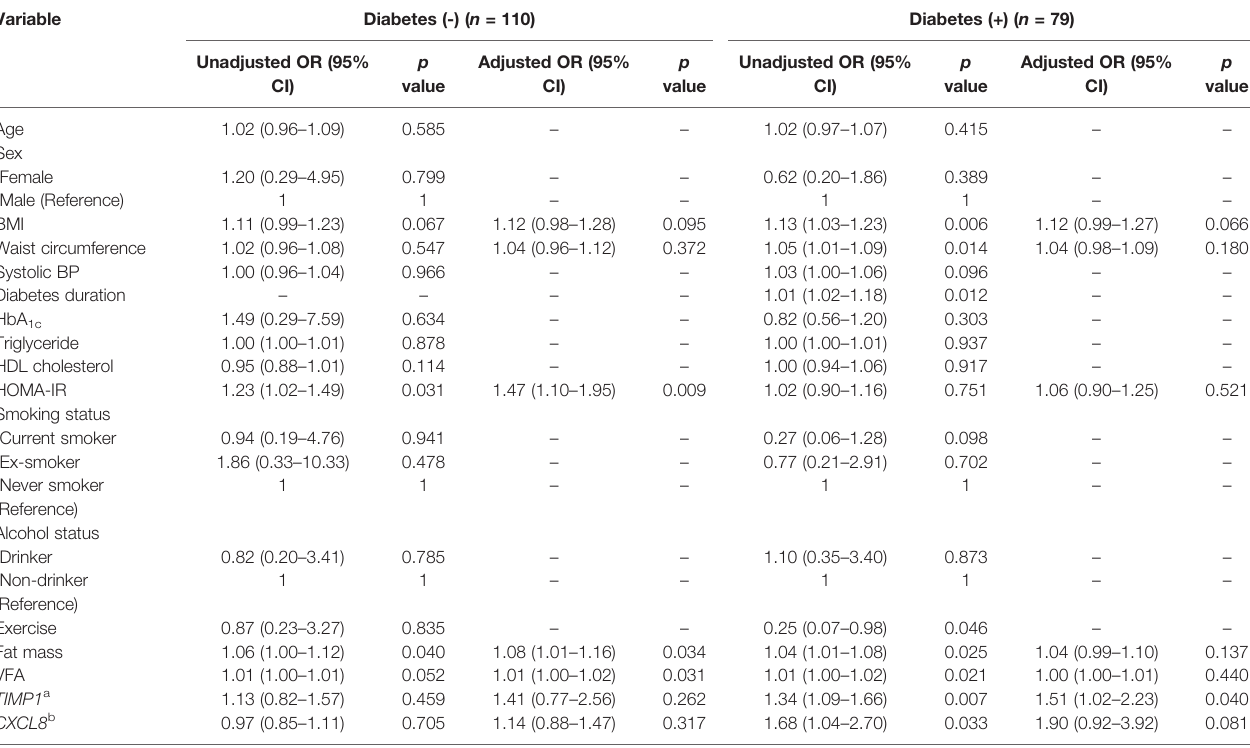
TABLE 2 | ORs and 95% CIs for polyneuropathy strati fi ed by diabetes. Variable Diabetes (-) ( n =